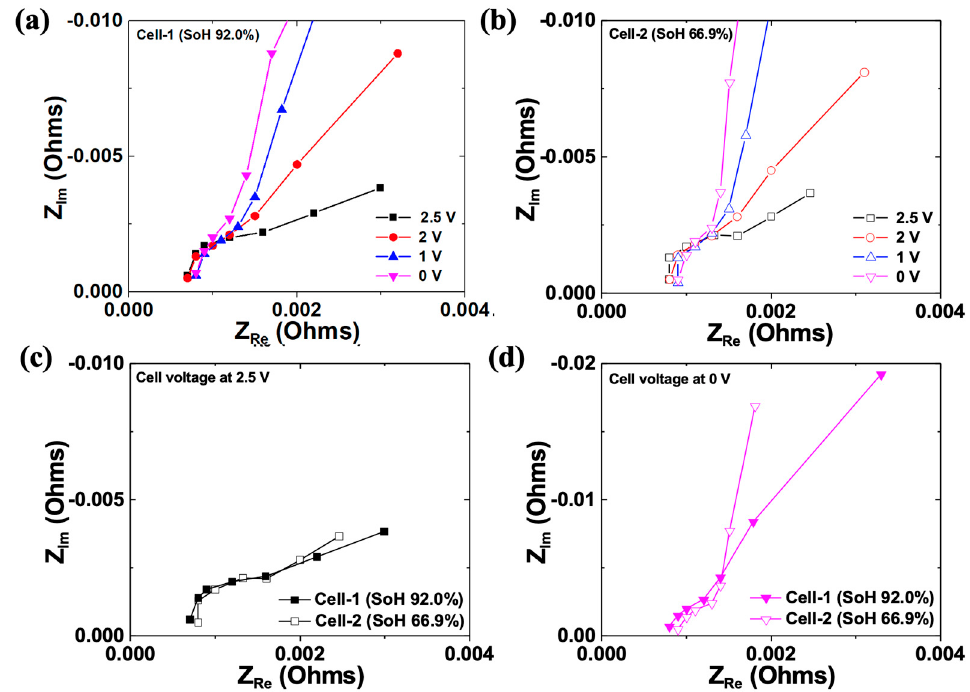
Figure 8. ( a , b ) Nyquist plots measured from cell-1 and a cell-2, discharged to various potentials, respectively. ( c , d ) Comparison of the Nyquist plots of cell-1 and cell-2, discharged to 2.5 and 0V, respectively.